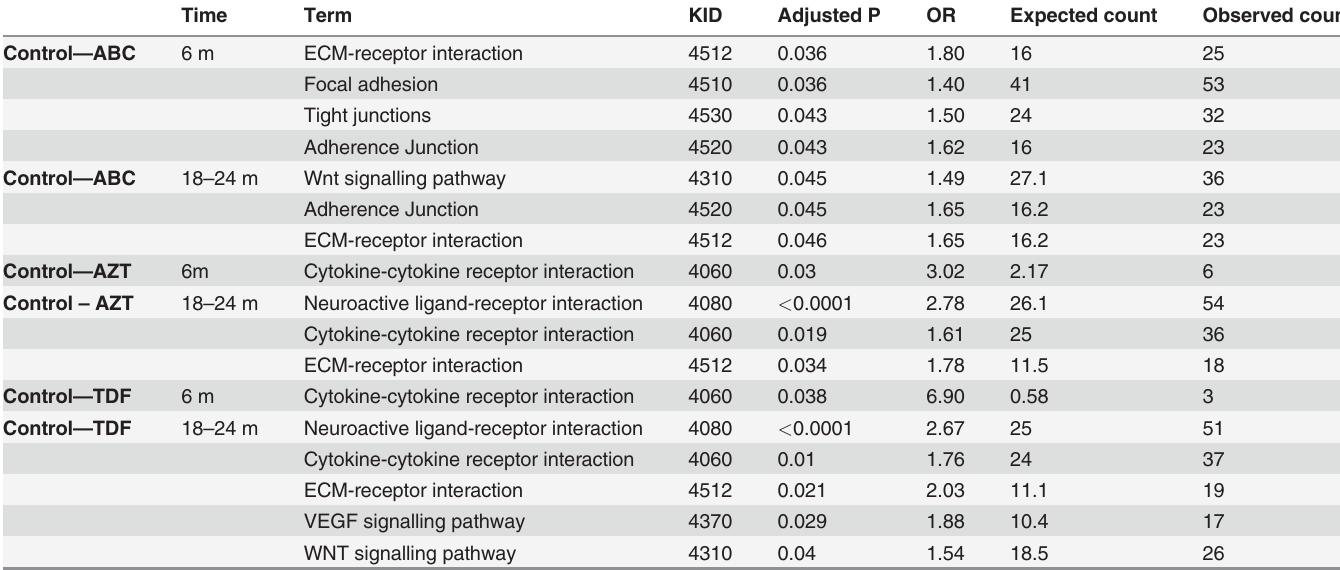
Table 2. Selected KEGG gene pathways relating to cell communication and environmental information processing that were signi fi cantly enriched compared to HIV negative controls.